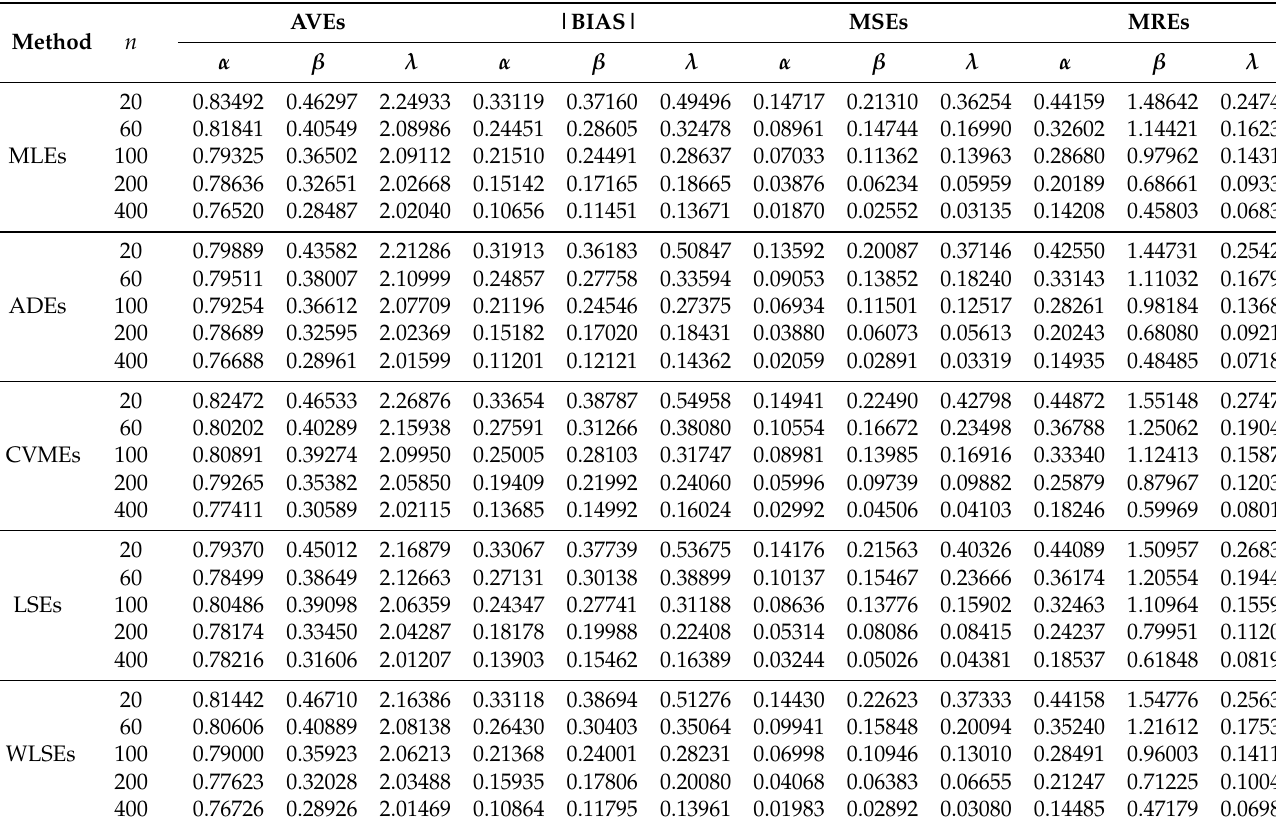
Table 7. Numerical values of the Ex-LL distribution for the parameters α = 0.75, β = 0.25, λ = 2.